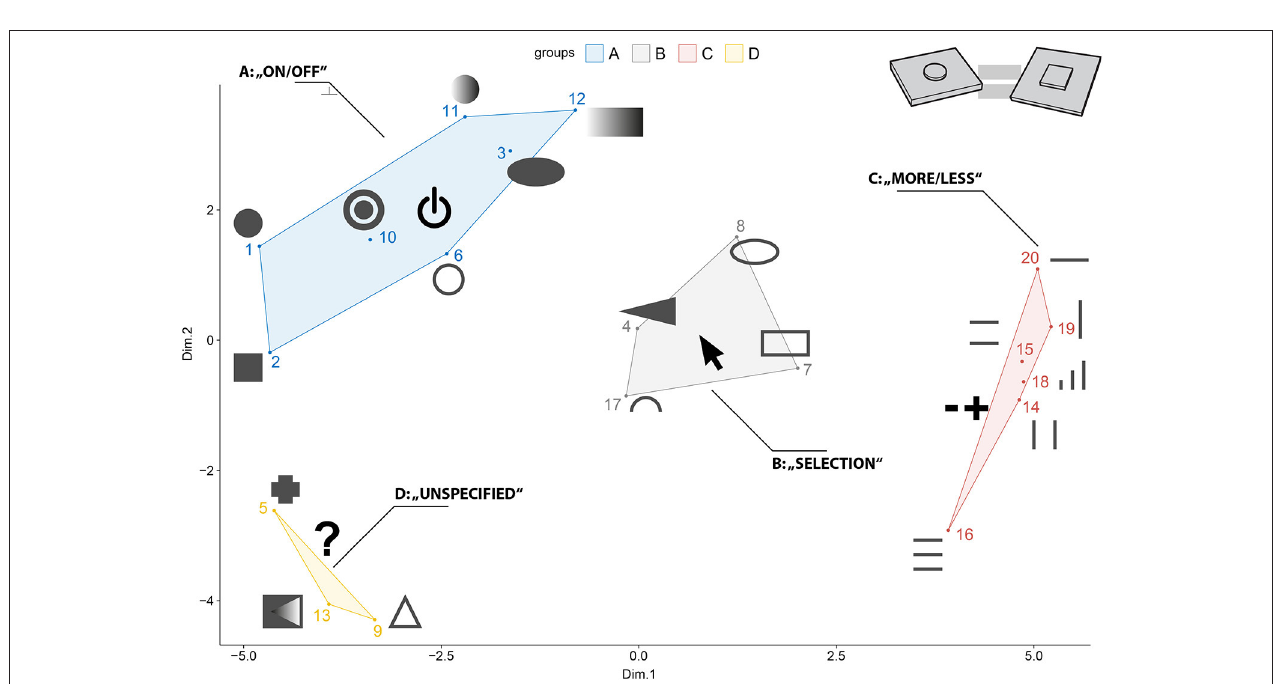
FIGURE 7 | The MDS procedure yielded four clusters that were interpreted with the following functional categories: (A) “on/off,” (B) “selection,” (C) “more/less,” (D) “unspecified”.